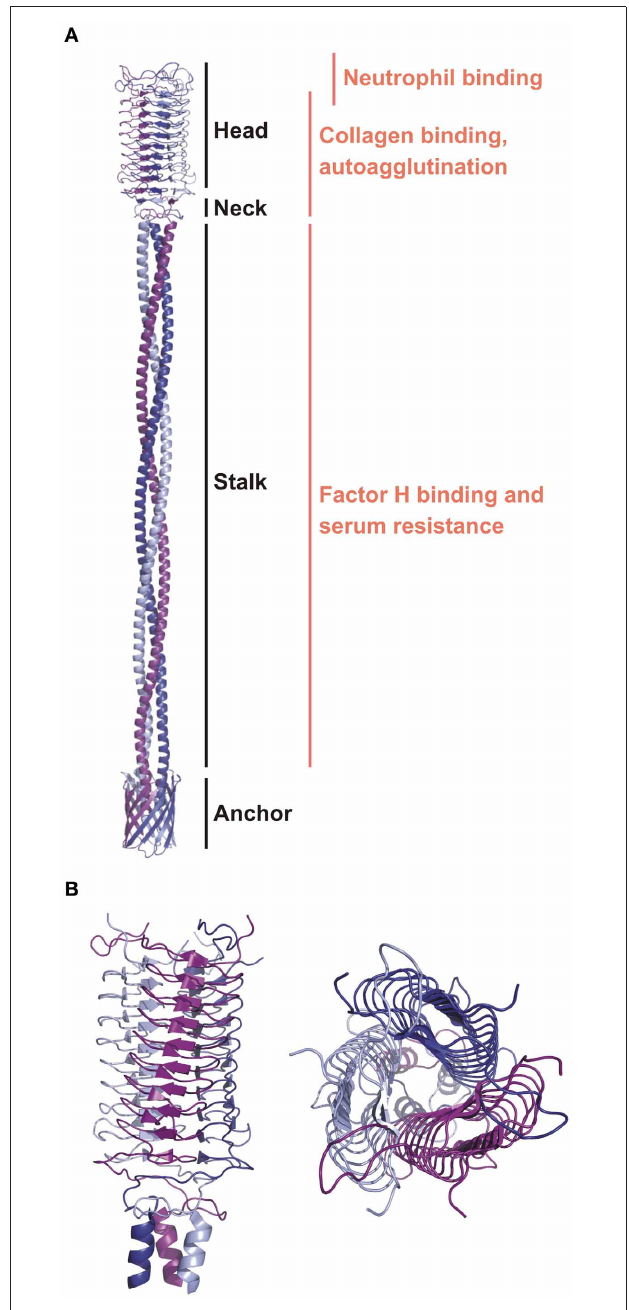
FIGURE 3 | The ribbon diagrams of YadA. (A) A general topology model of YadA created based on the experimental structure of the head region and modeled stalk and anchor regions (Koretke et al., 2006). Modular organization and binding regions for different ligands are annotated. (B) The crystal structure of the YadA head domain from Y. enterocolitica (1P9H). Left panel is a side view showing the LPBR fold. The top view on the right panel presents trimeric organization of YadA.